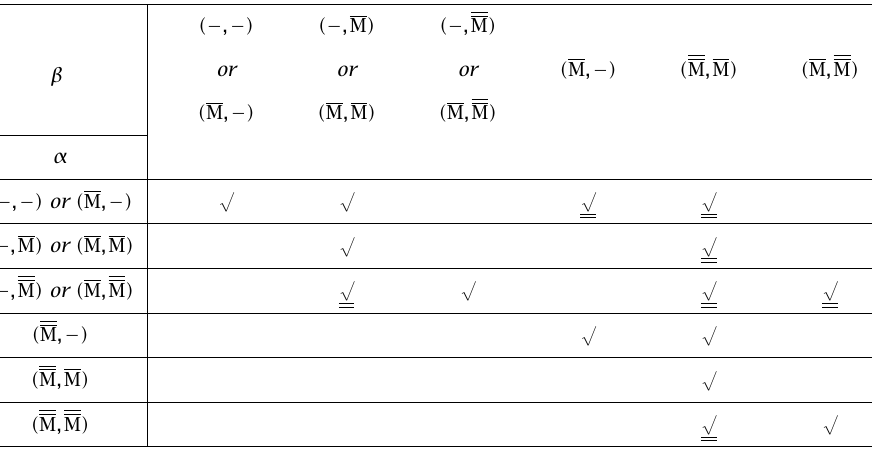
√ Table 1.5 . The mark indicates that for the corresponding case if B is A α almost periodic, then B is A β almost periodic, and The mark cates that for the corresponding case if B is A α almost periodic and A